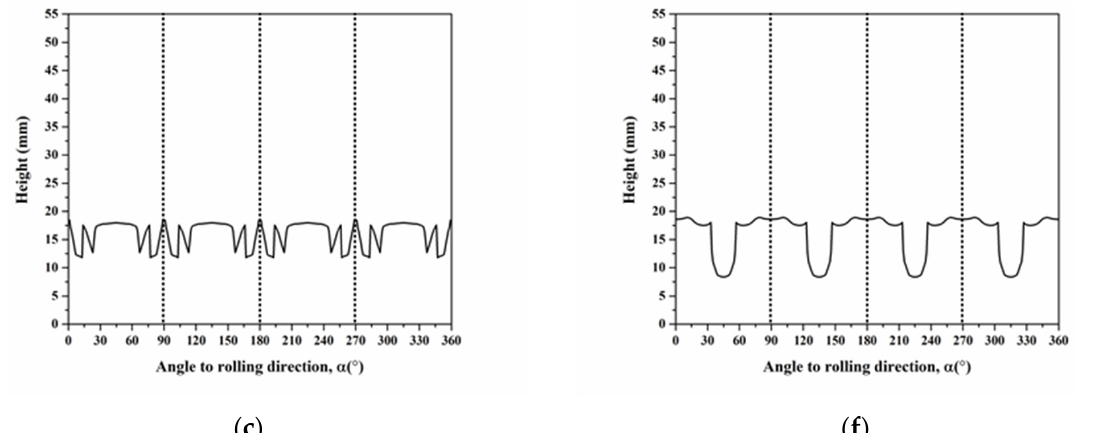
Figure 14. Cup height profiles as a function of the angle for texture components of ( a ) C, ( b ) S, ( c ) B, ( d ) Cube, ( e ) r-Cube, and ( f ) G considering the multi-slip systems.